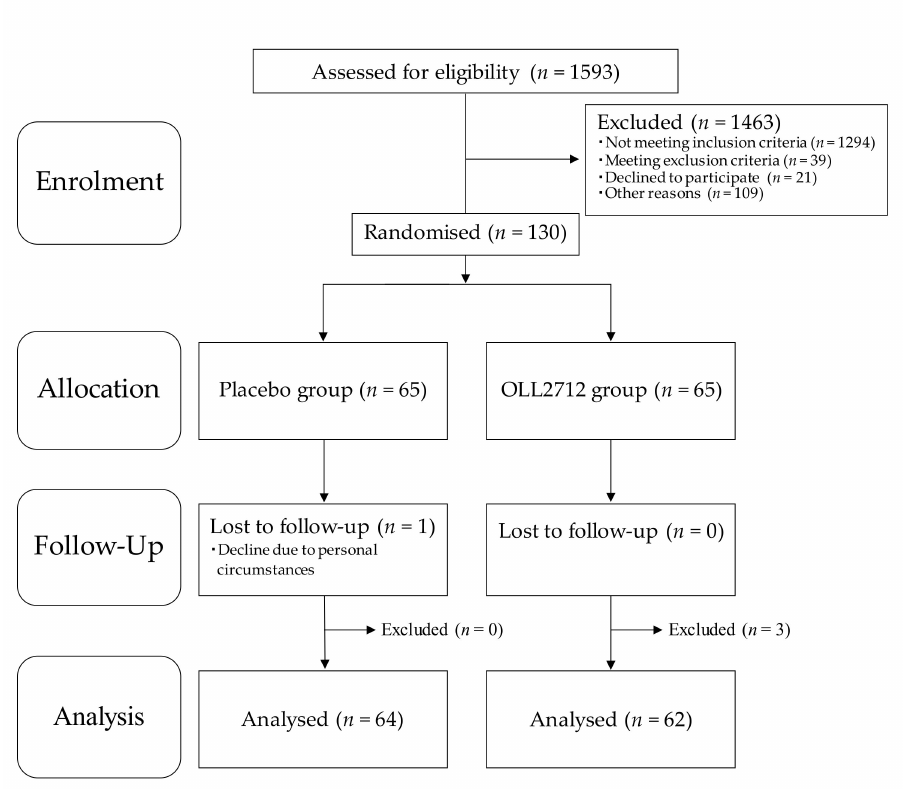
Figure 1. Flowchart of study participants: Placebo, conventional yogurt; OLL2712, yogurt containing more than 5 × 10 9 heat-treated Lactobacillus plantarum OLL2712